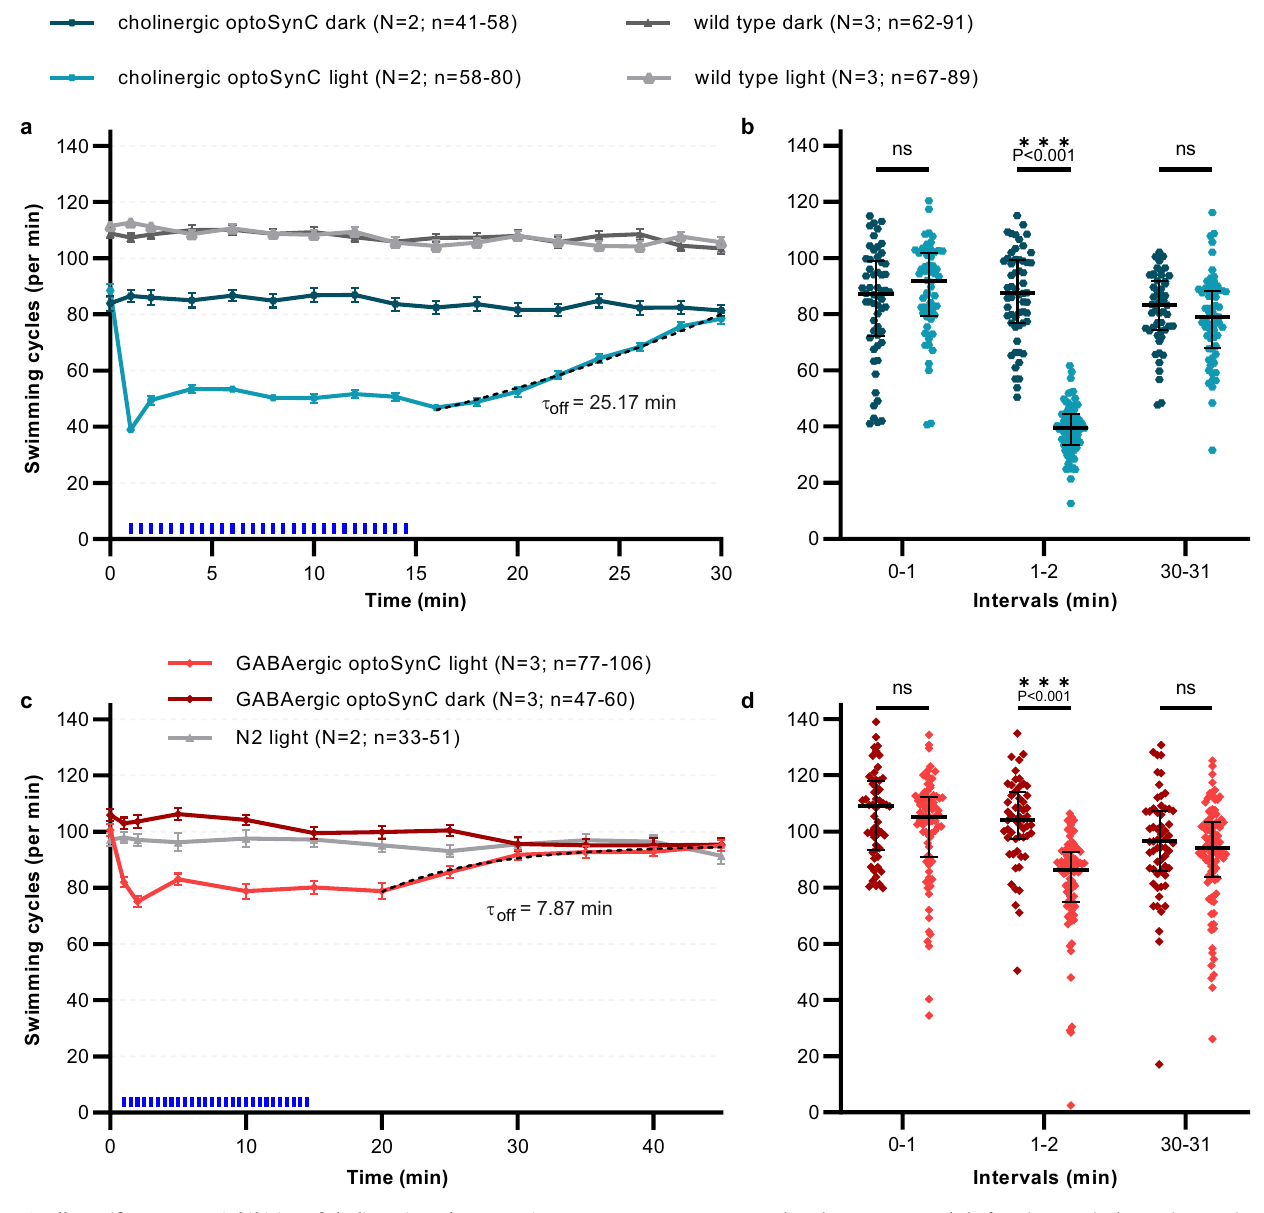
Fig.7|Cell-speci fi coptoSynCinhibitionofcholinergicandGABAergicneurons. a Swimming behavior in animals expressing optoSynC in cholinergic neurons. Blue light activation (470nm, 0.1mW/mm², 5s/25s ISI) indicated by blue rec- tangles. Dotted line: ‘ plateau followed by one phase association ’ - fi t. Error bars are s.e.m. Number of individual animals ( n ) across independent experiments ( N , i.e. animals picked from N independent populations) is indicated as range. b Swimming cycles of individual animals, median and 25 – 75 % IQR of N =2 – 3